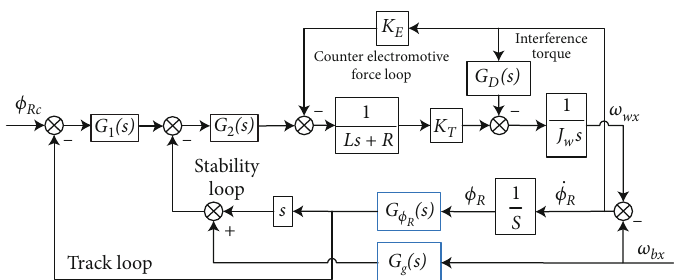
Figure 3: DRR model of the roll loop.